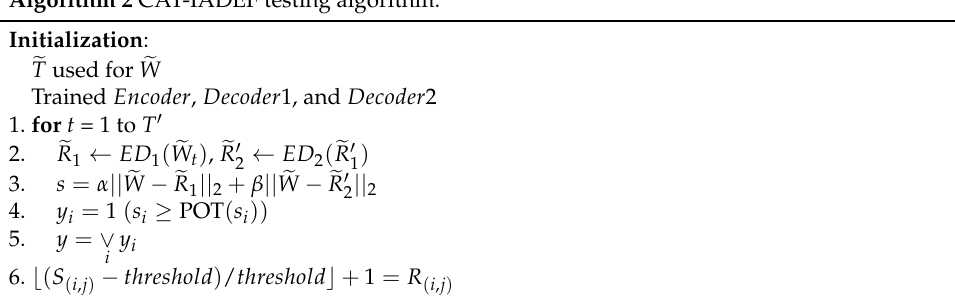
Algorithm 2 CAT-IADEF testing